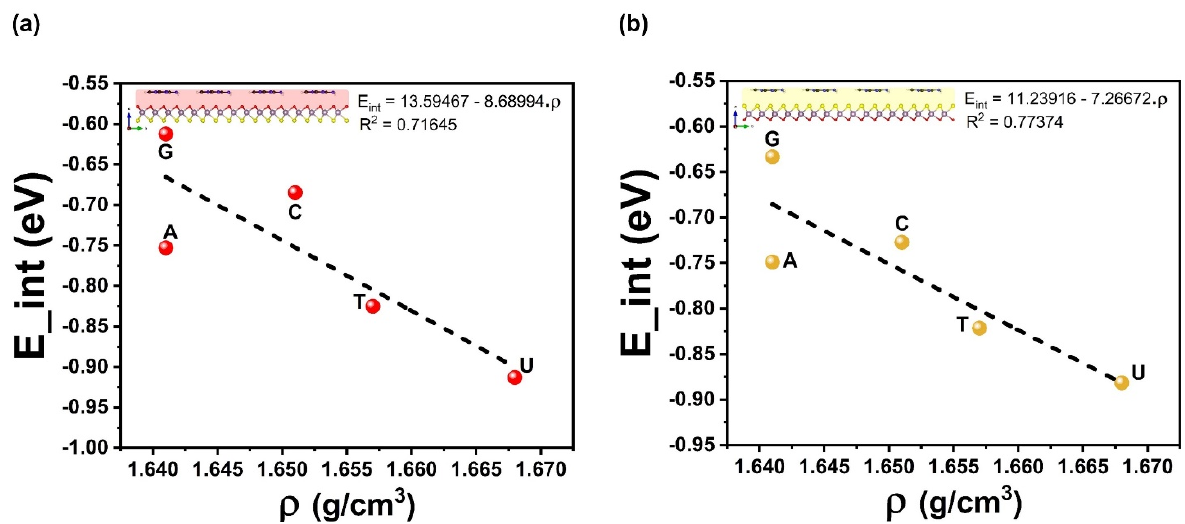
Figure 4. The interaction energy as function of density affinity of the nucleobases molecules on the Janus MoOS monolayer facets, ( a ) on O layer, ( b ) on S layer, respectively.